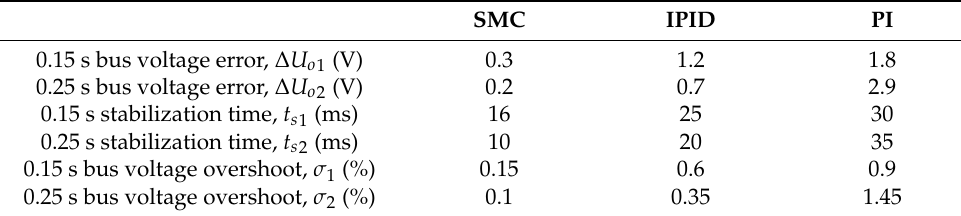
Table 2. Comparison of SMC, IPID and PI with sudden load changes.